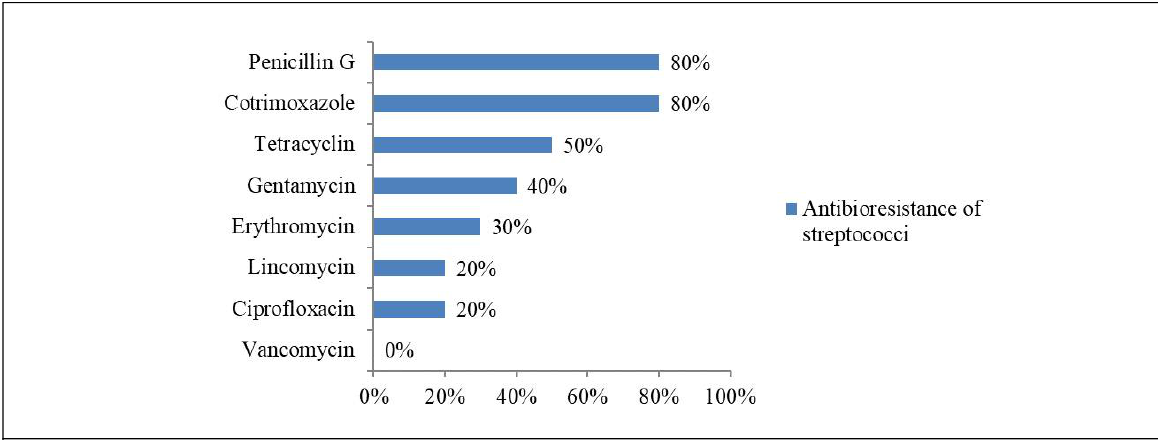
Figure 3: Antibiotic resistance of